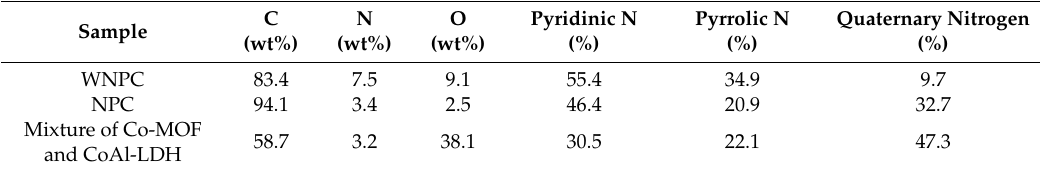
Table 1. Elemental analysis results for NPC, WNPC and the carbonized sample of the mixture of Co-MOF and